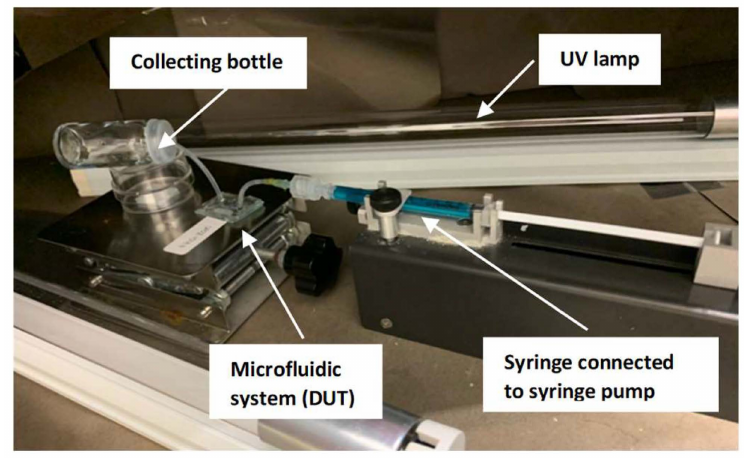
Figure 2. Photocatalytic experiment setup.